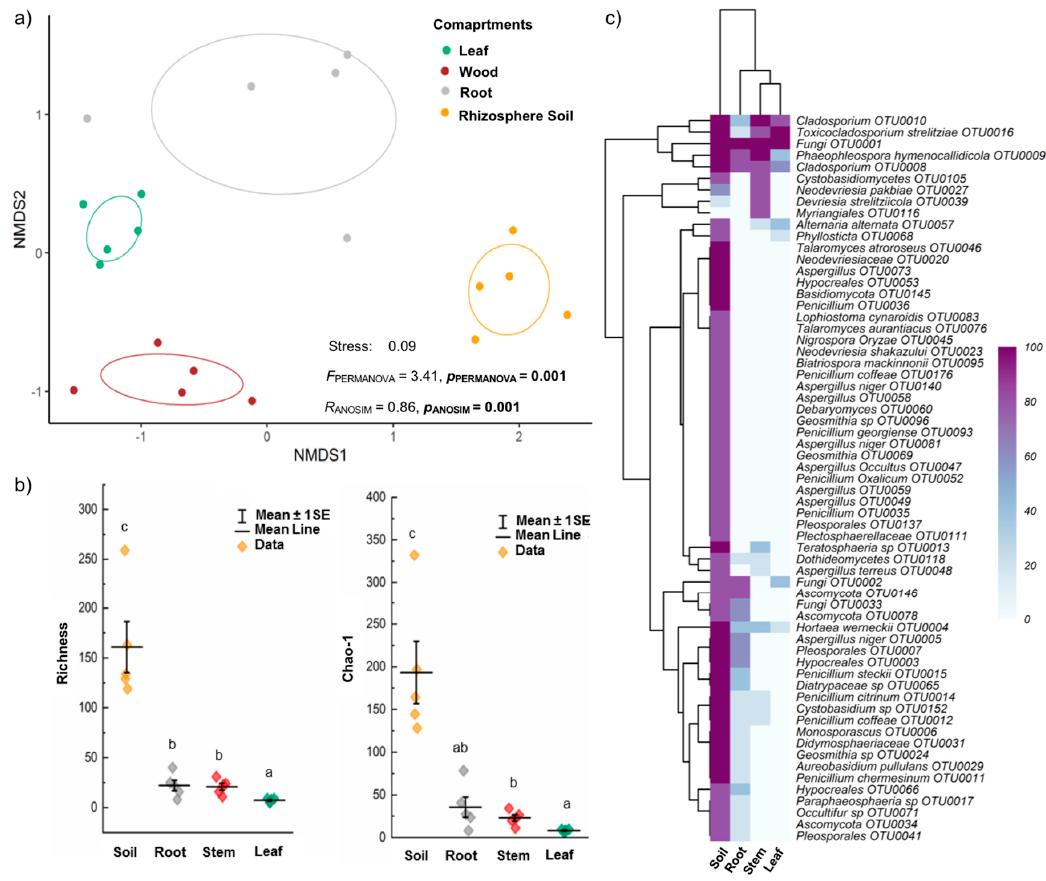
Figure 5. Fungal community composition and richness across the R. stylosa (rhizosphere soil and plant compartments: ( a ) non-metric multidimensional scaling plot of fungal communities in indicated compartments, showing 95% confidence ellipses around mean values of NMDS axes 1 and 2; ( b ) fungal OTU and Chao1-estimated OTU richness (means ± SE), and ( c ) heatmap of dominant fungal OTUs based on percent occurrence data (accounting for ≥ 80% of OTUs in at least one compartment). Different letters above OTU/Chao1 richness bars within a panel indicate significant differences ( p < 0.05) according to analysis of variance or Kruskal-Wallis tests.